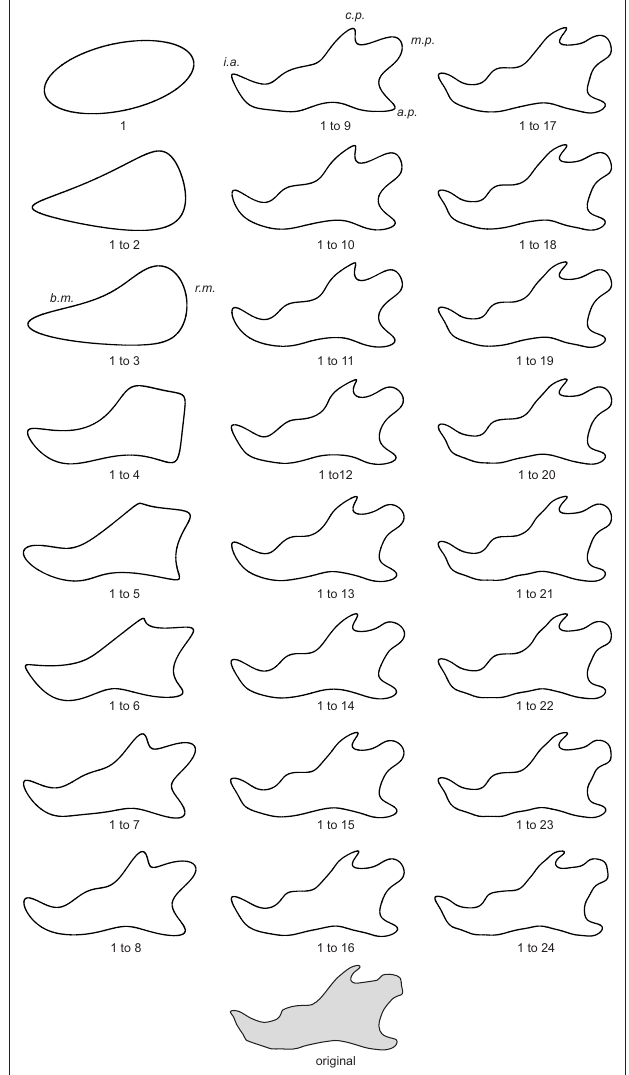
Figure 2 | Morphological analysis of the step-by-step elliptical Fourier reconstructions. Example of a lateral mandibular outline reconstruction in hemizygous Eda Ta/Y mice using the 24 first Fourier harmonics. The ramus and the body of the mandible (r.m. and b.m. respectively) started to be described with the second and third harmonics. The coronoid process (c.p.), the mandibular condyle (m.c.), and the angular process (a.p.) appeared with the fifth harmonic. The mandibular notch and the concavity of the posterior border of the ramus were reconstructed together with the previous anatomical structures. Coronoid process, mandibular condyle, and angular process were correctly outlined with the summation of the 9th harmonic, and subtle features of these three parts of the mandible were characterized from the 16th harmonic. The height of the body of the mandible was defined around fourth and fifth harmonics. The incisor alveolar bone (i.a.) appeared with the fourth harmonic and a correct description was acquired using the first